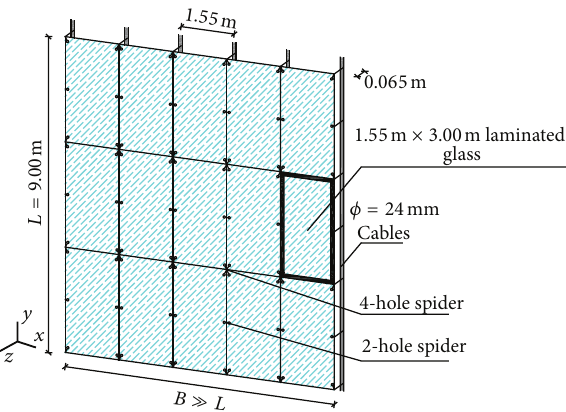
Figure 1: Schematic view of the studied cable-supported fac¸ade.